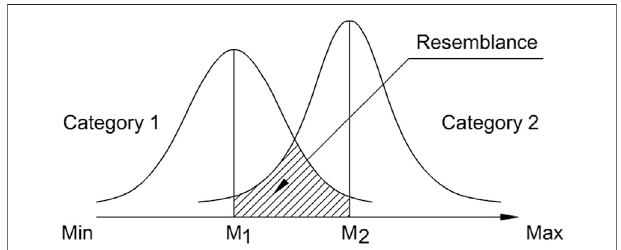
FIGURE 2 | Conceptualisation of the process of subjective comparison of two